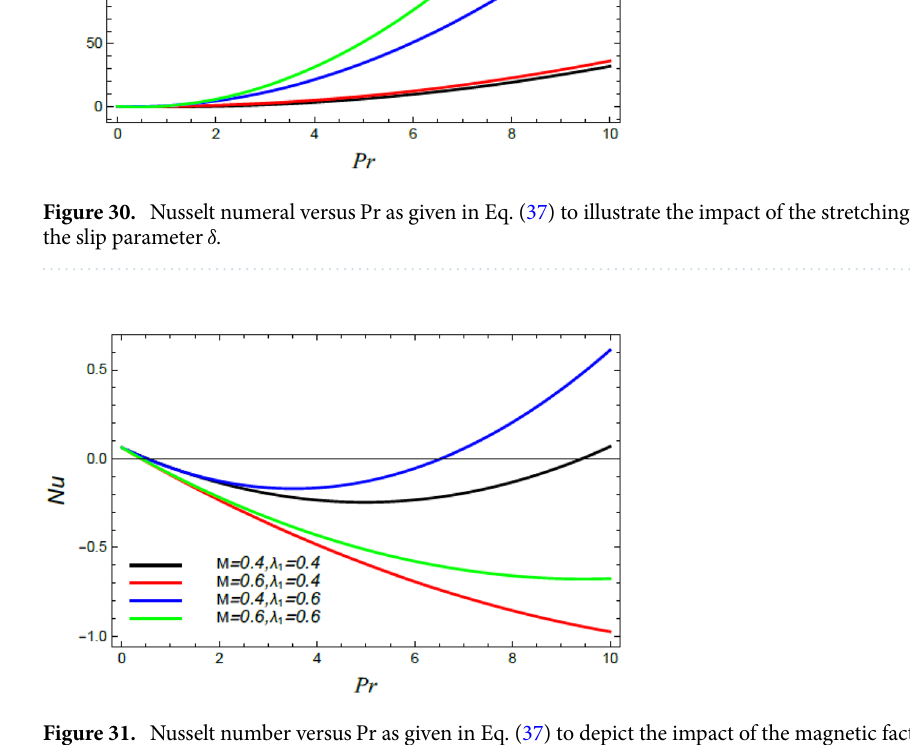
Figure 31. Nusselt number versus Pr as given in Eq. (37) to depict the impact of the magnetic factor M and the heat dispersion parameter (cid:31) 1 .